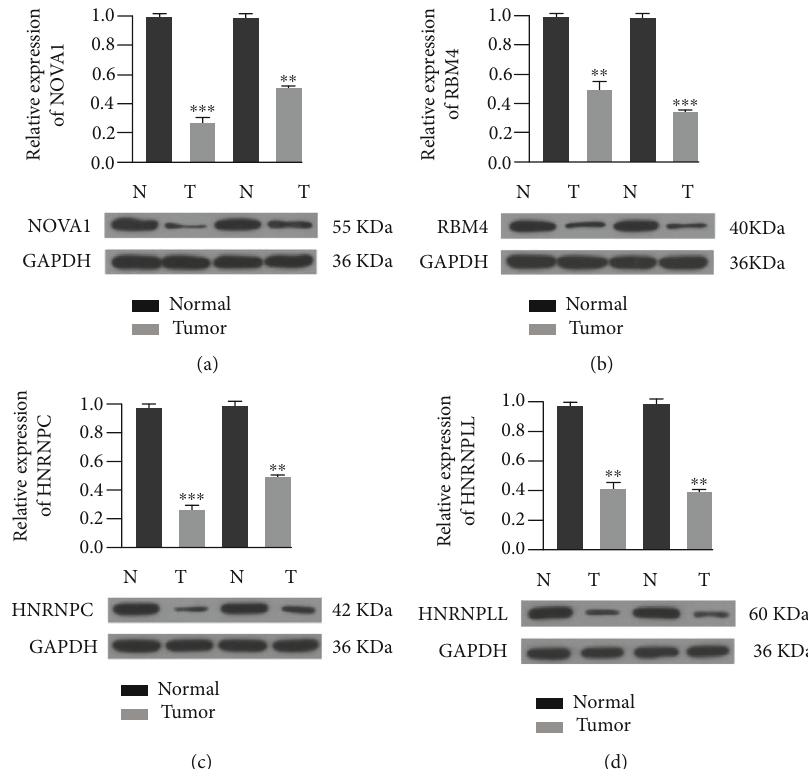
Figure 6: Western blotting detected the expression levels of four SFs in glioma and nontumor tissues. ∗∗ p < 0 : 01 , ∗∗∗ p < 0 : 001